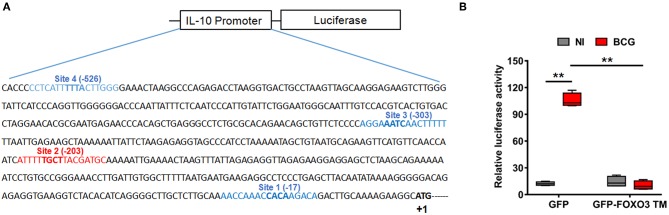
FOXO3 inhibits IL-10 promoter activity in BCG-infected macrophages. (A) Schematic representation of the four putative Forkhead DNA-binding elements (FKHR-DBEs) in the proximal region of the human IL-10 promoter (-588), identified by Genomatix algorithm. The sequence in red is a typical FOXO3 binding motif. (B) RAW 264.7 cells were co-transfected with pGL3 plasmid containing the −588 bp IL-10 promoter region fragments plus either the GFP or GFP-FOXO3-TM-encoding vectors. Twenty-four hours later, cells were infected or not with BCG (MOI ~10) for 6 h before measuring the Luciferase activity in GFP positive alive cells. The data correspond to the mean ± SEM and correspond to a one representative of two independent experiments, each one conducted in triplicates (n = 2, **p < 0.01).